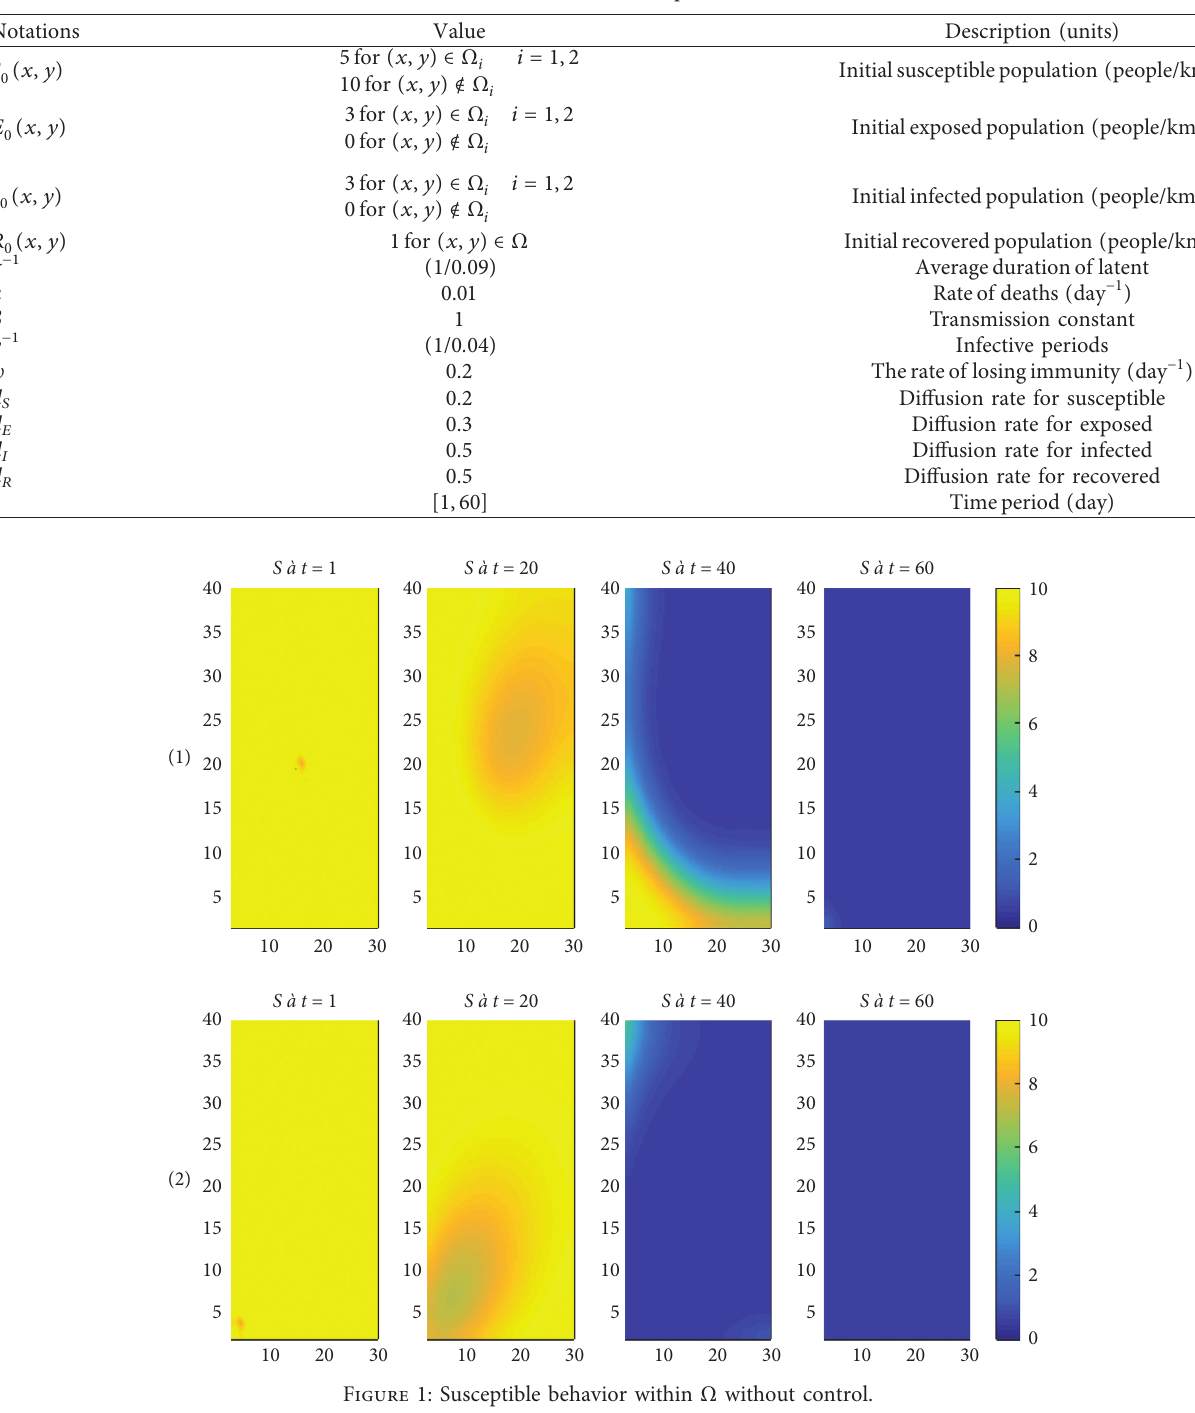
Table 1: Initial conditions and parameter